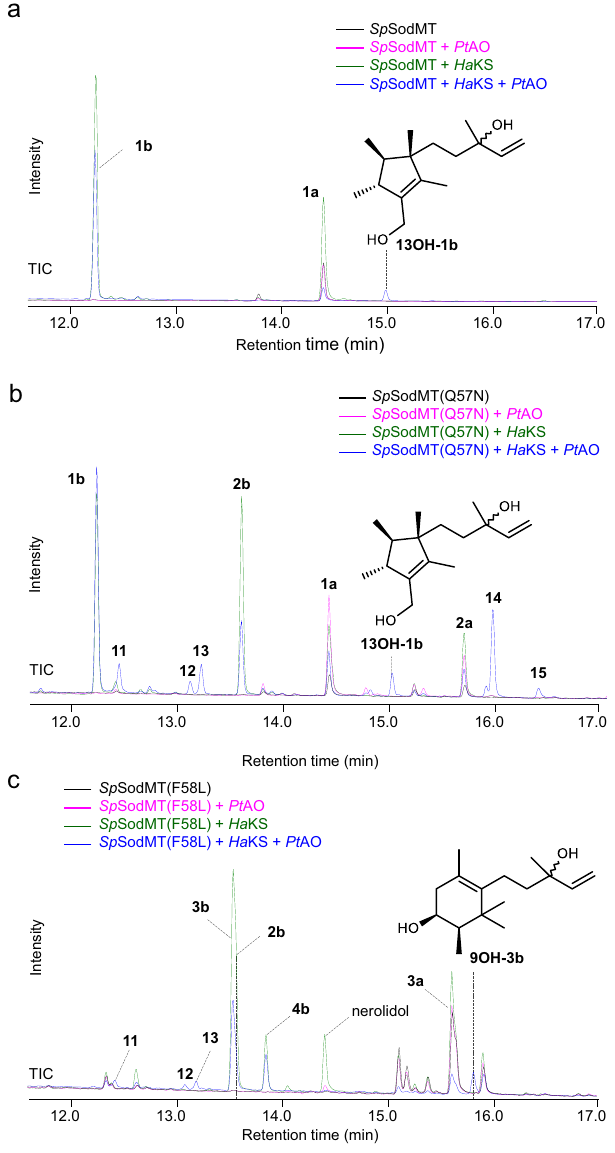
Fig. 6 | Production of complex C 16 terpenes by CYP720B1. Chromatograms showing the productpro fi le of CYP720B1( Pt AO) in yeast cells co-expressing Ha KS with Sp SodMT wild-type or variants (blue) versus control cells transformed with Sp SodMT wild-type or variants but lacking Ha KS or Pt AO or both. a In PSPP- producing yeast cells, Pt AO oxidized 1b to produce 13OH-1b . b When, both PSPP- and PPP-derived C 16 alcohols were produced by yeast cells, Pt AO produced 13OH- 1b and compounds 11 - 15 . c In cells expressing Sp SodMT(F58L), Pt AO produced 9OH-3b from 3b